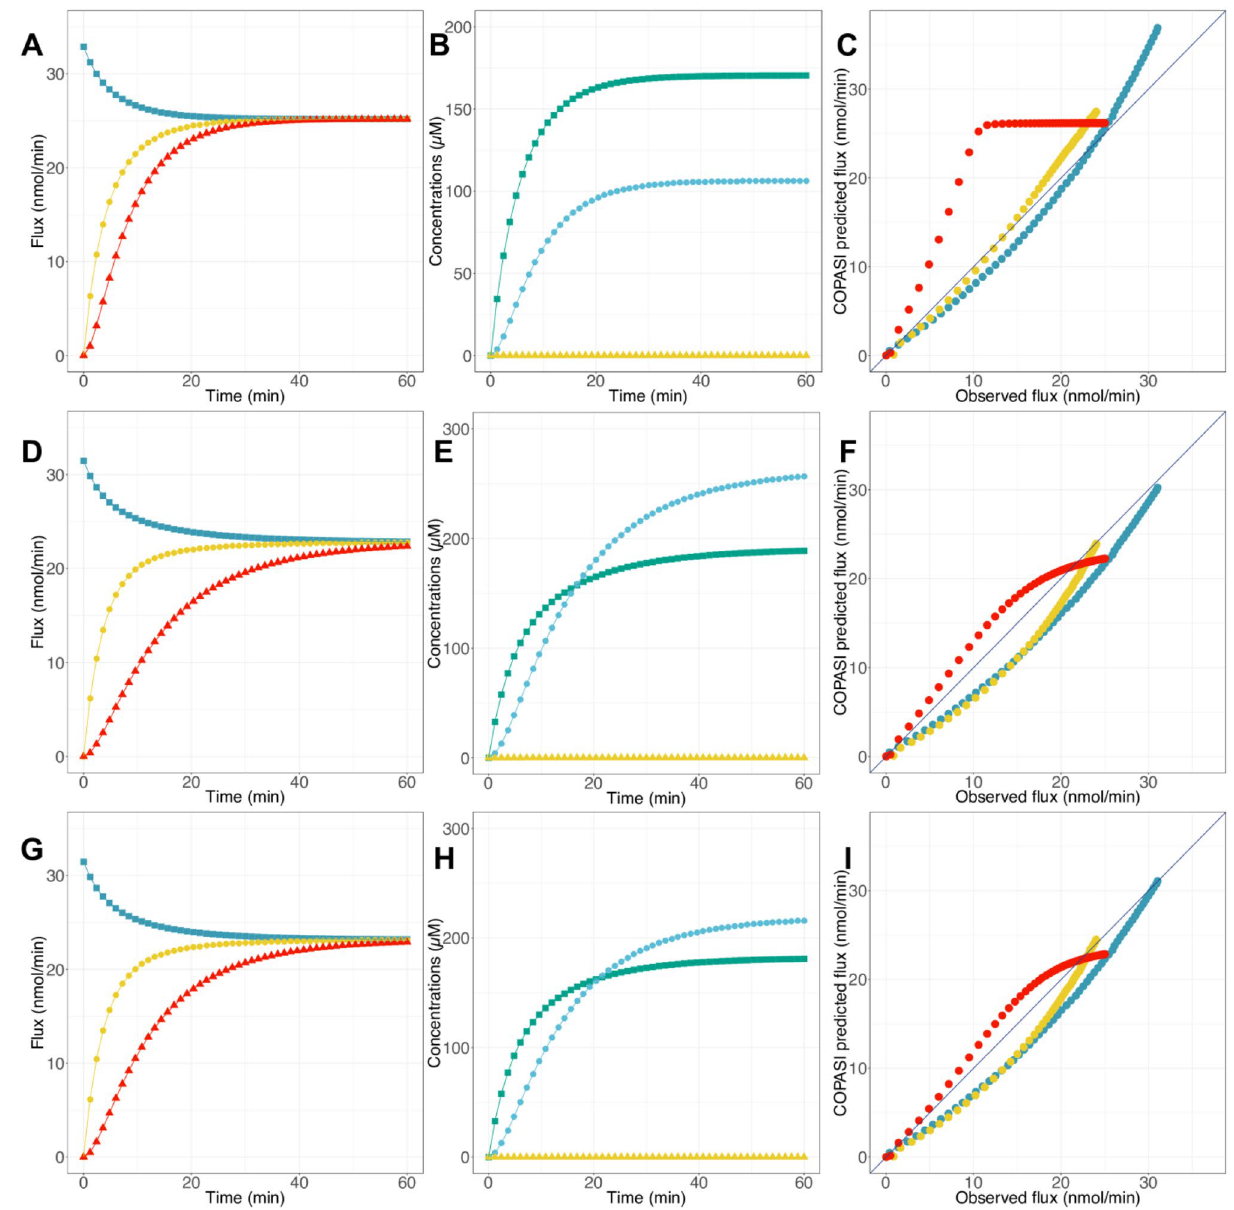
Figure 5. Flux and metabolite concentration predictions with COPASI models. ( A , D , G ) PGAM (blue squares), ENO (yellow circles) and PPDK (red triangles) flux predicted as function of time with the adjusted Moreno-Sanchez model ( A ), the model containing UUBB equation ( D ) and the improved model containing UUBB equation ( G ). ( B , E , H ) 2PG (green), PEP (blue) and Pyr (yellow) concentration predicted with the adjusted Moreno-Sanchez model ( B ), the model containing UUBB equation ( E ) and the improved model containing UUBB equation ( H ). ( C , F , I ) Flux predictions by the adjusted Moreno-Sanchez model ( C ), the model containing UUBB equation ( F ) and the improved model containing UUBB equation ( I ). Circle colors refer to the various levels of enzyme activity: PGAM (blue), ENO (yellow) or PPDK